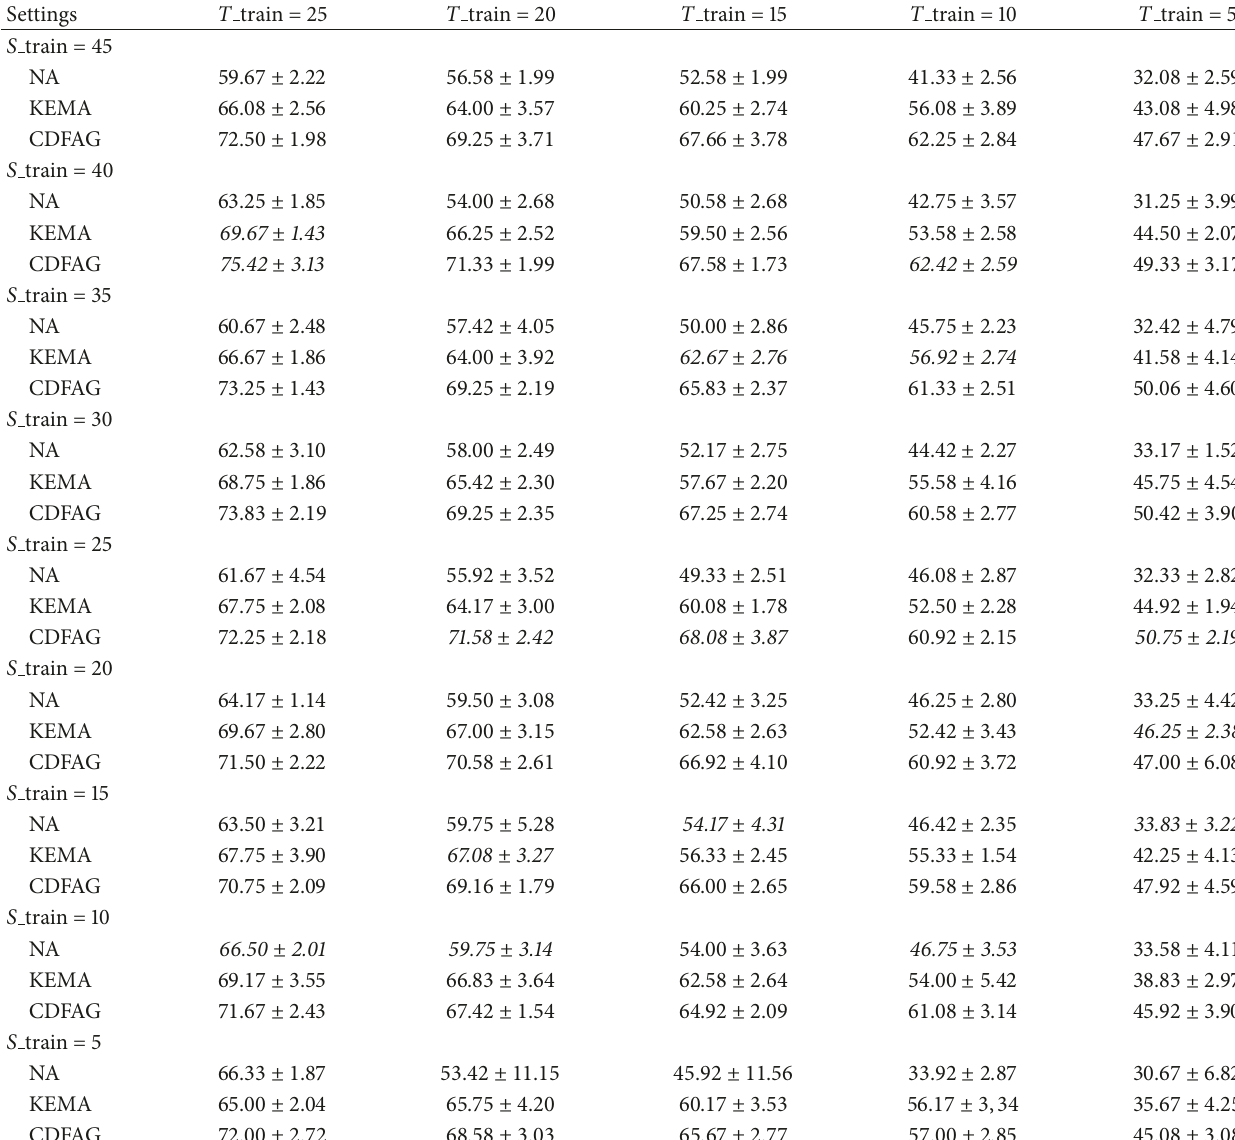
Table 2: The average recognition precision (%) of No Adaptation (NA), KEMA, and the proposed CDFAG in target dataset InfAR. S train and T train denote the number of training samples in source and target datasets, respectively. Best accuracies of each column for each method are marked in